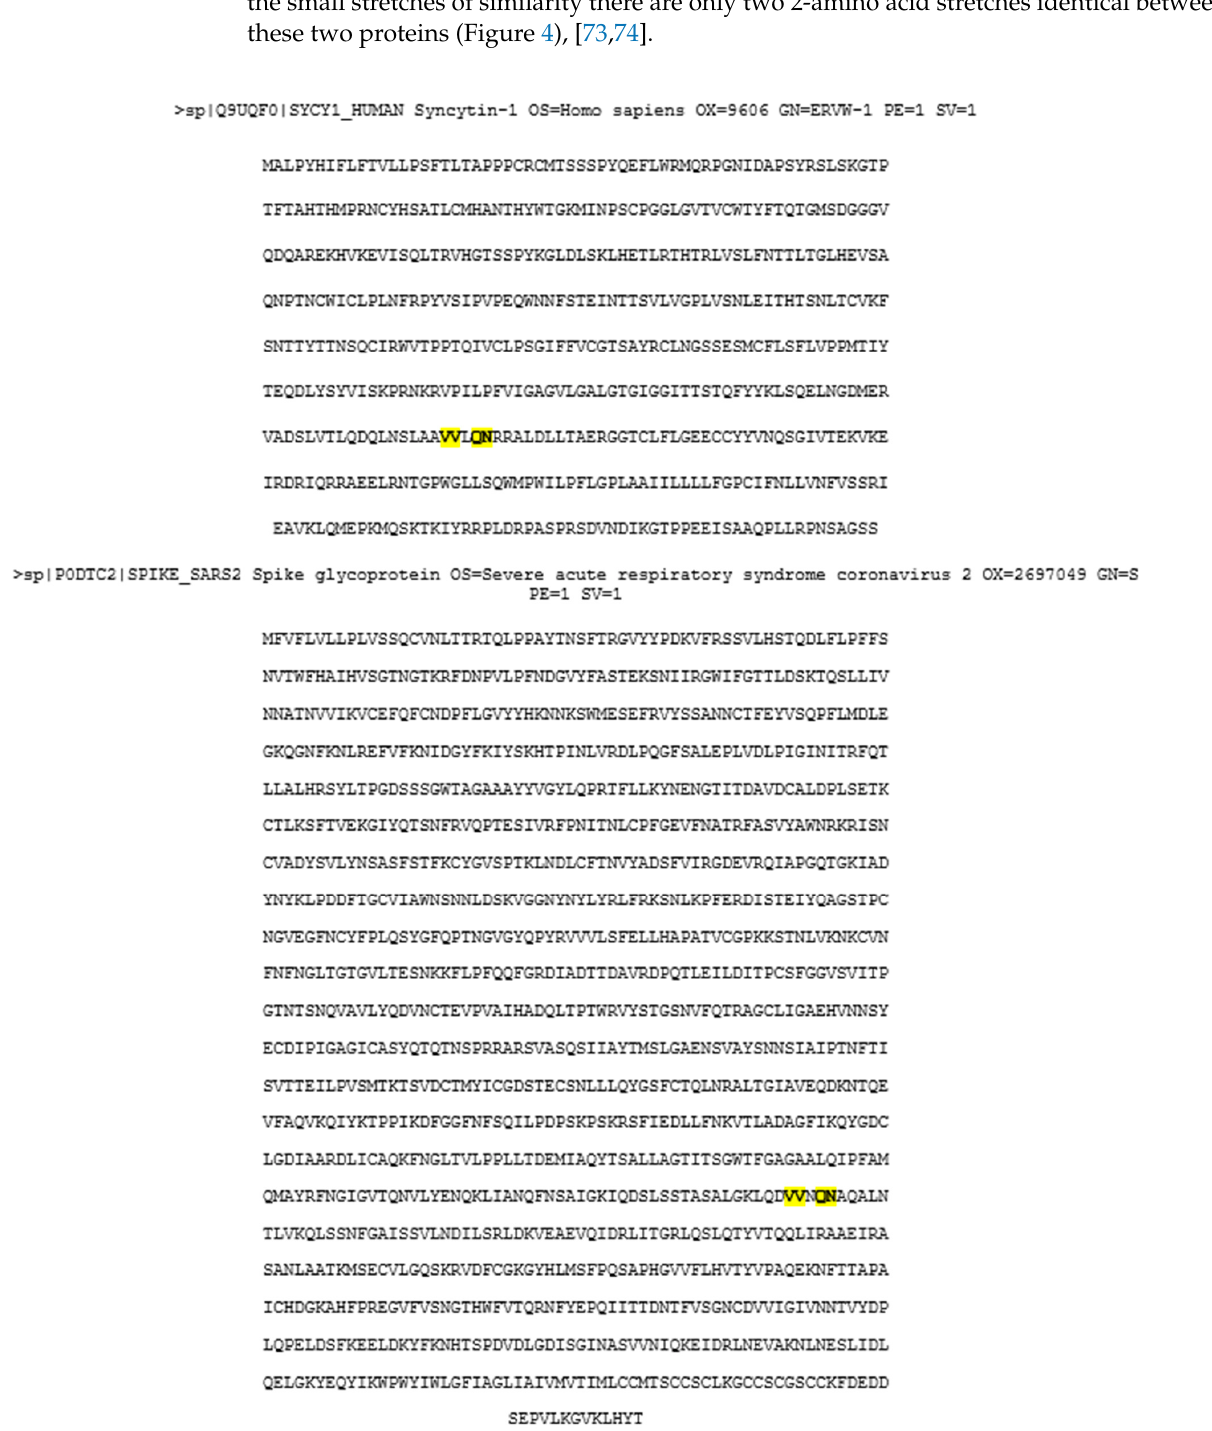
Figure 4. The comparison between amino acid sequences of human syncytin-1 and the spike protein of SARS-CoV-2. The Blast comparison of these two sequences does not show any similarities. How- ever, the search for the similarity between 5-amino acid stretches (marked in yellow) shows two 2-amino acid identities (marked in red). Such very limited similarity is very unlikely to cause cross-reactivity between anti-SARS-CoV-2 antibodies and the human syncytin-1 protein.